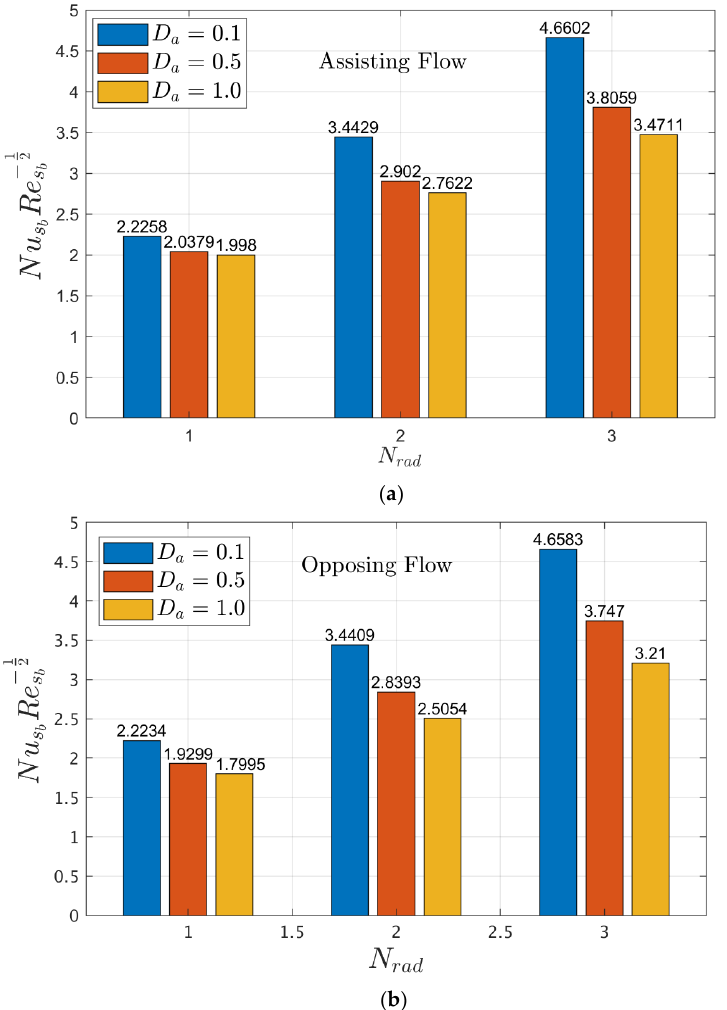
Figure 12. The bar graph represents the heat transfer against N rad for the case of ( a ) assisting flow and ( b ) opposing flow with various values of the curvature parameter radius.